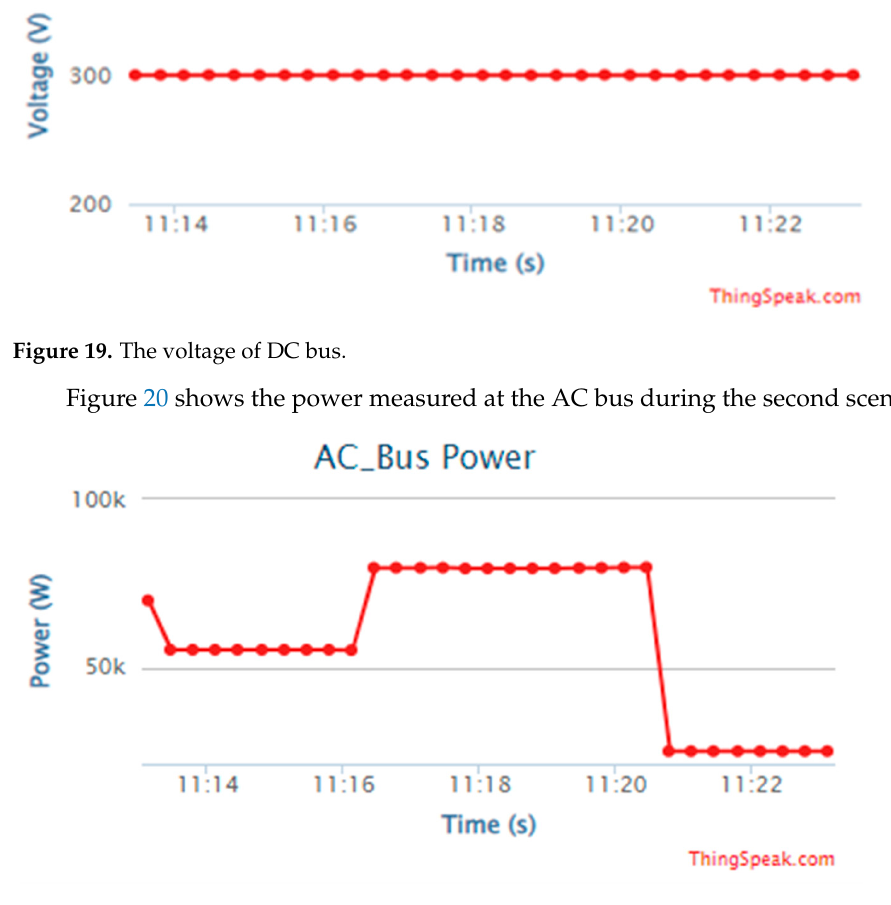
Figure 20. Power at the AC bus.